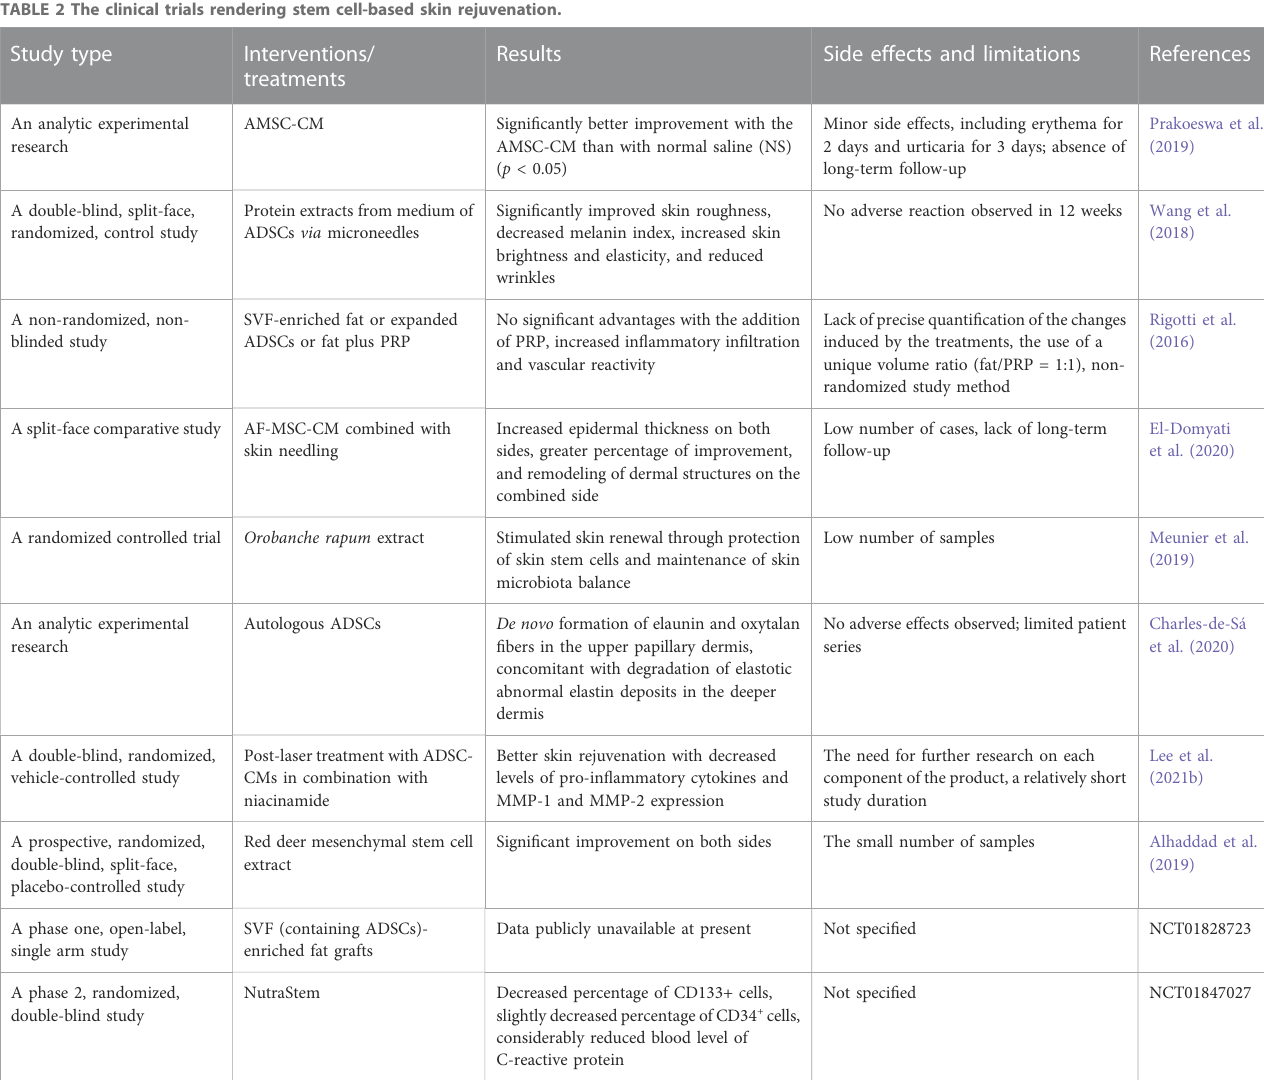
TABLE 2 The clinical trials rendering stem cell-based skin